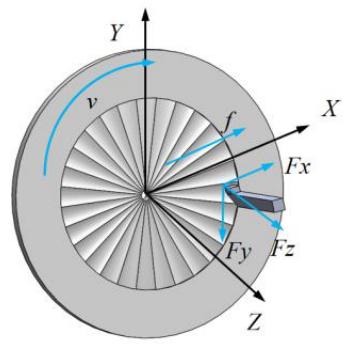
Figure 3. Surface waviness formation process.